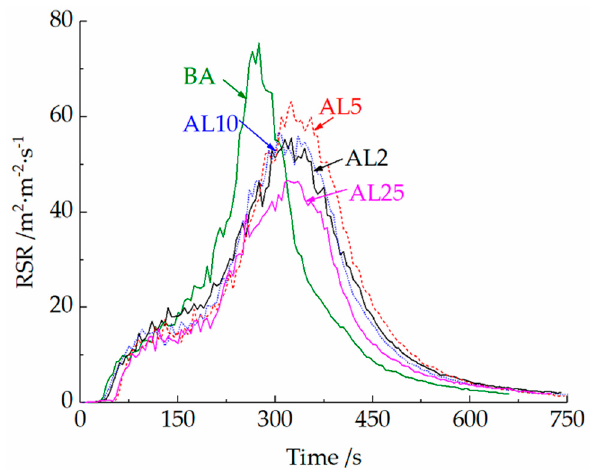
Figure 7. Smoke release rate of asphalt binders.